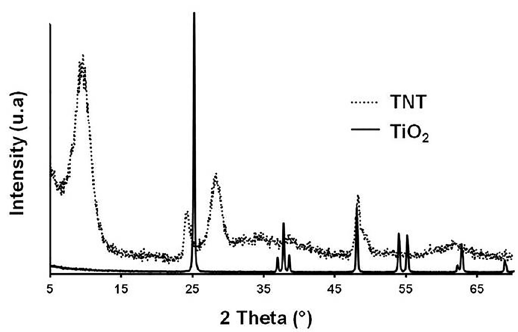
Figure 3. XRD results of TiO